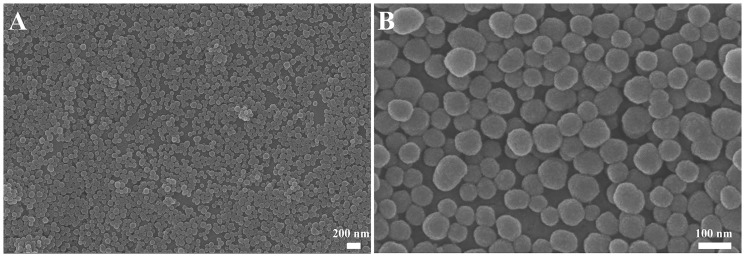
SEM Images of spherical silica NPs. The average size of silica NPs is ∼50 nm